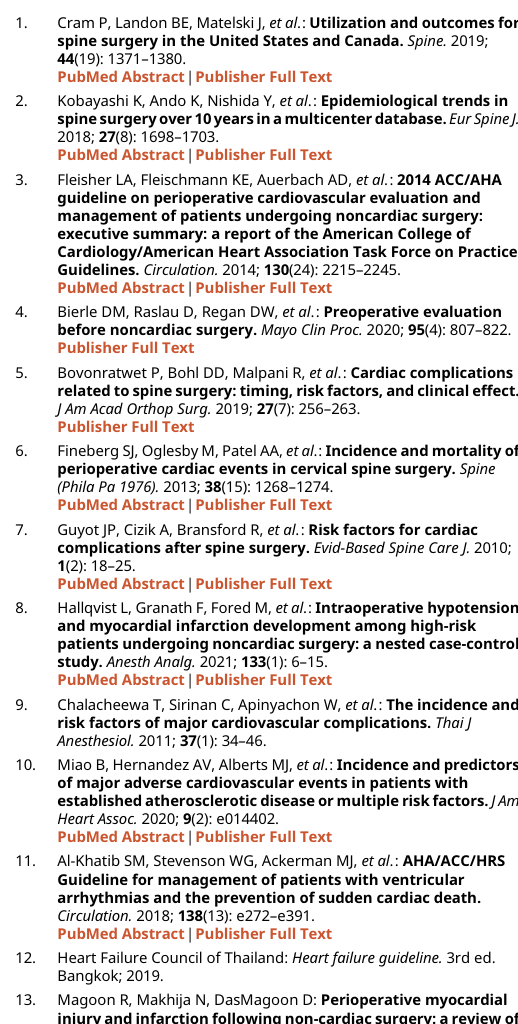
Data are available under the terms of the Creative Commons Zero “ No rights reserved ” data waiver (CC BY 4.0 Public domain